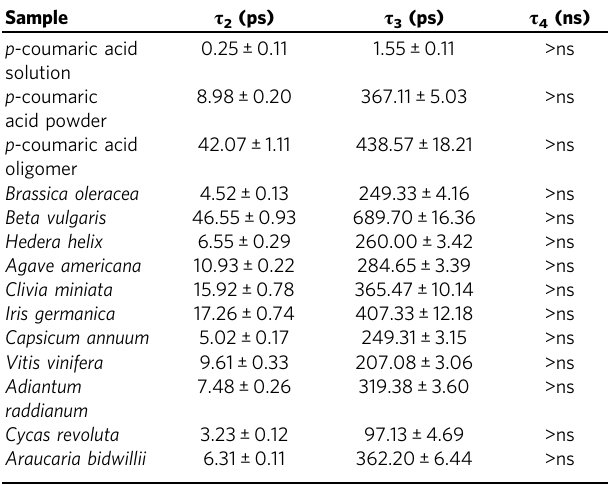
Table 1 Sequential lifetimes of the excited state